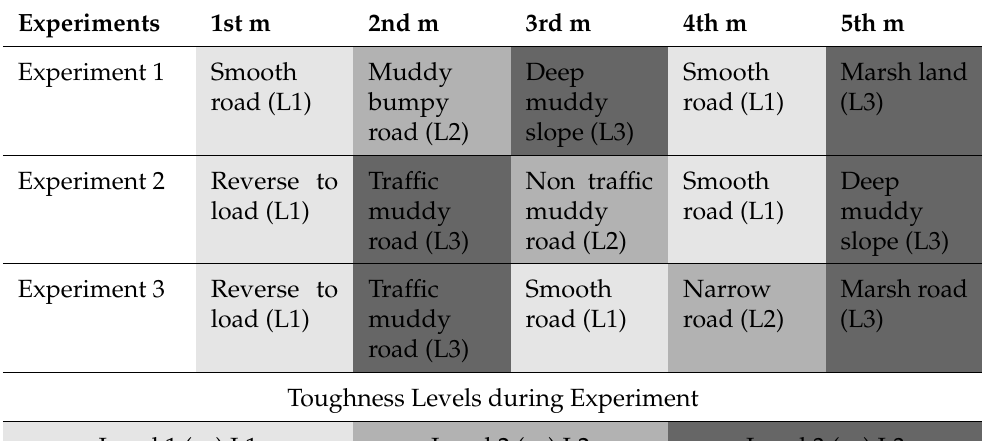
Table 1. Experiment situation and levels of toughness with regard to time